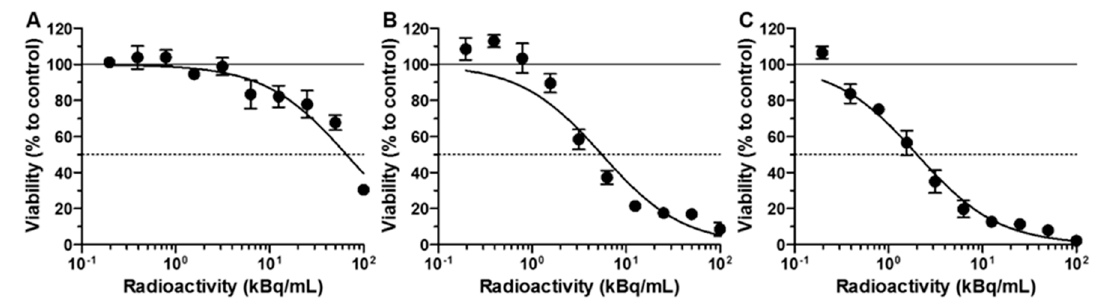
ff erent radioactive doses of 225 Ac ( A